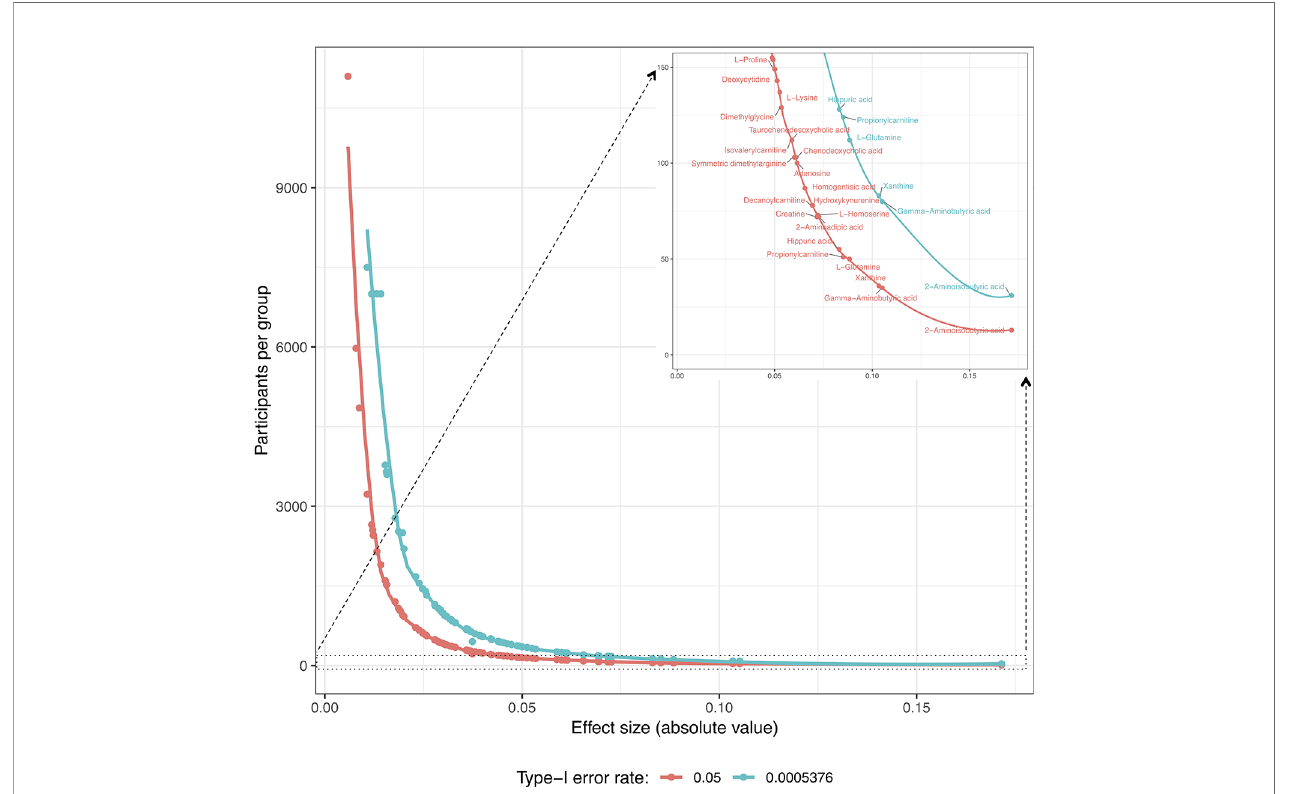
FIGURE 4 | Estimation of the number of participants per group required for the signi fi cant detection of “ Time × Group ” coef fi cients (type-I error rates: 0.05 and 5.576 · 10 − 4 ; minimum detection power: 80%) for each metabolite according to the coef fi cient values obtained in these study models. In the upper right corner, there is a resized section of the overall curves clarifying the metabolites for which the estimated number of participants per group is ≤